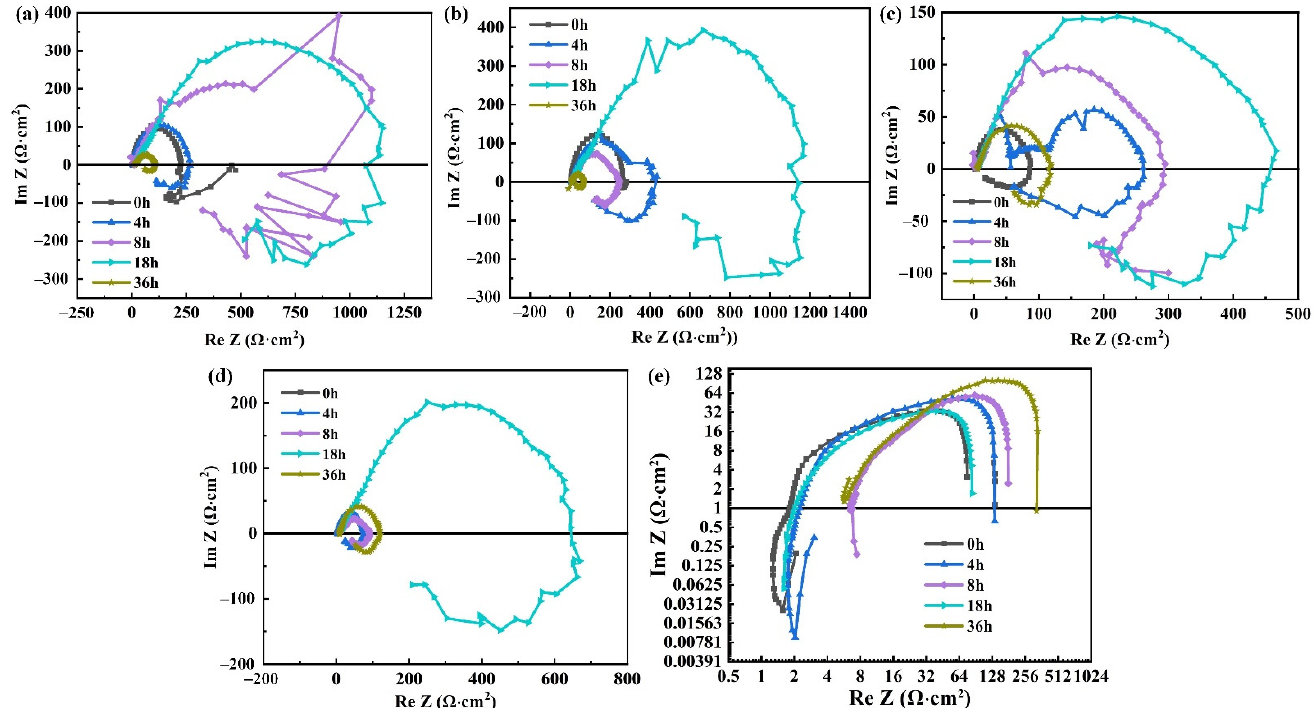
Figure 8. Electrochemical impedance spectroscopy of ZK61M alloy in different Cl − concentrations: ( a ) 0.2 mol/L, ( b ) 0.4 mol/L, ( c ) 0.6 mol/L, ( d ) 0.8 mol/L and ( e ) 1.0 mol/L.